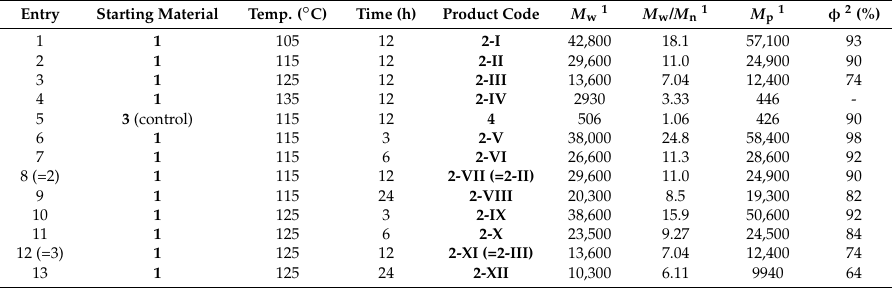
Table 1. Conditions and results for the radical crossover